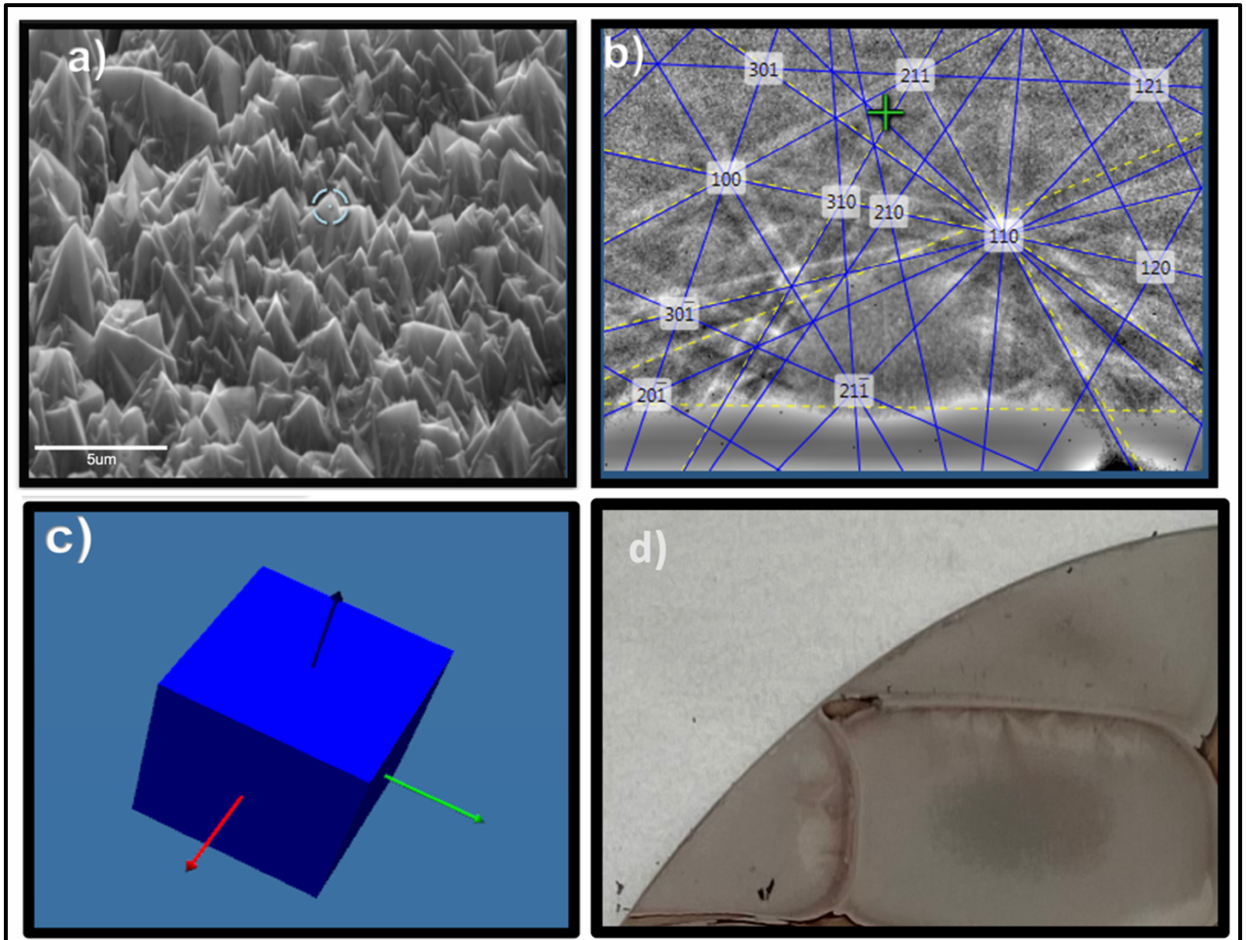
Figure 7. ( a ) HRSEM showing the formation of <100> oriented diamond over large area. ( b ) EBSD pattern at 70 ◦ . ( c ) Orientation relationship diagram showing the crystal structure of <100> diamond growth ( d ) Optical image of the annealed large-scale integrated